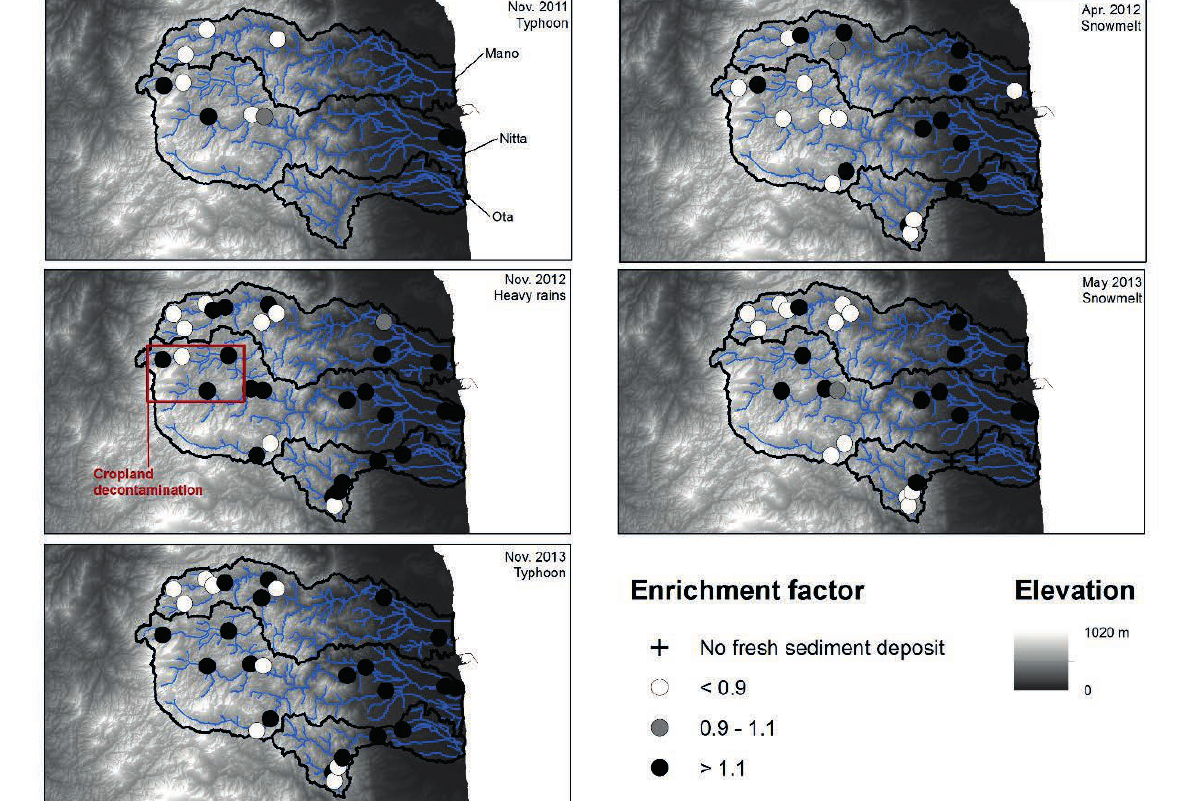
Fig. 3 Evolution of radiocaesium enrichment factor along rivers in the three study catchments during the five fieldwork campaigns. The red square indicates the part of the Nitta catchment where decontamination works were under progress during autumn in